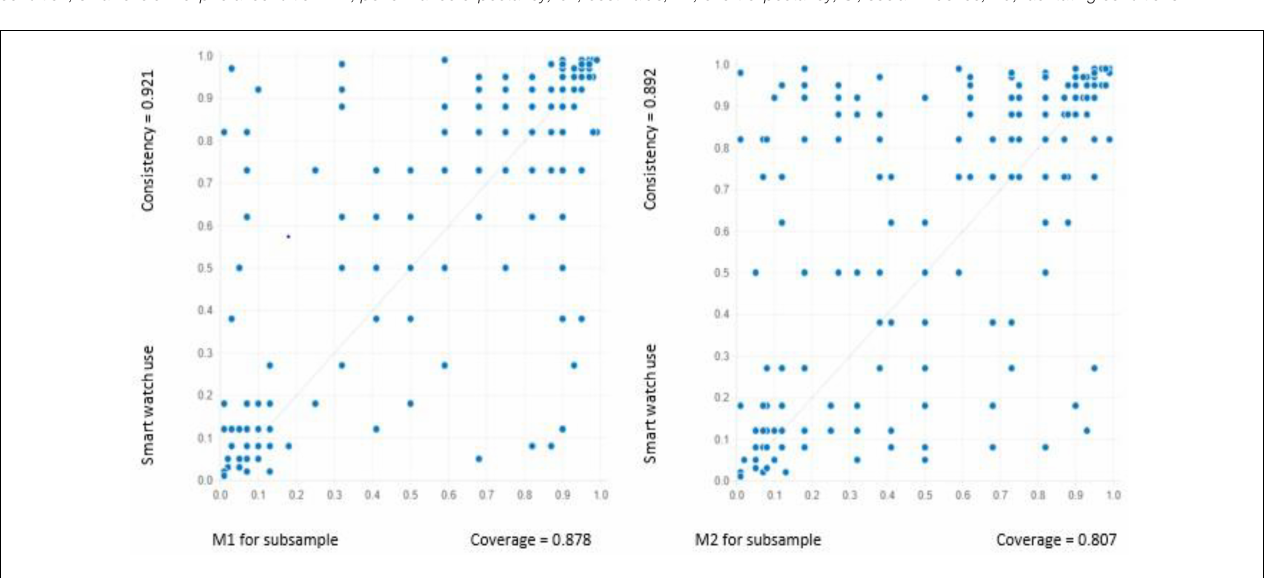
FIGURE 2 | Models 1 and 2 are tested using data from the holdout